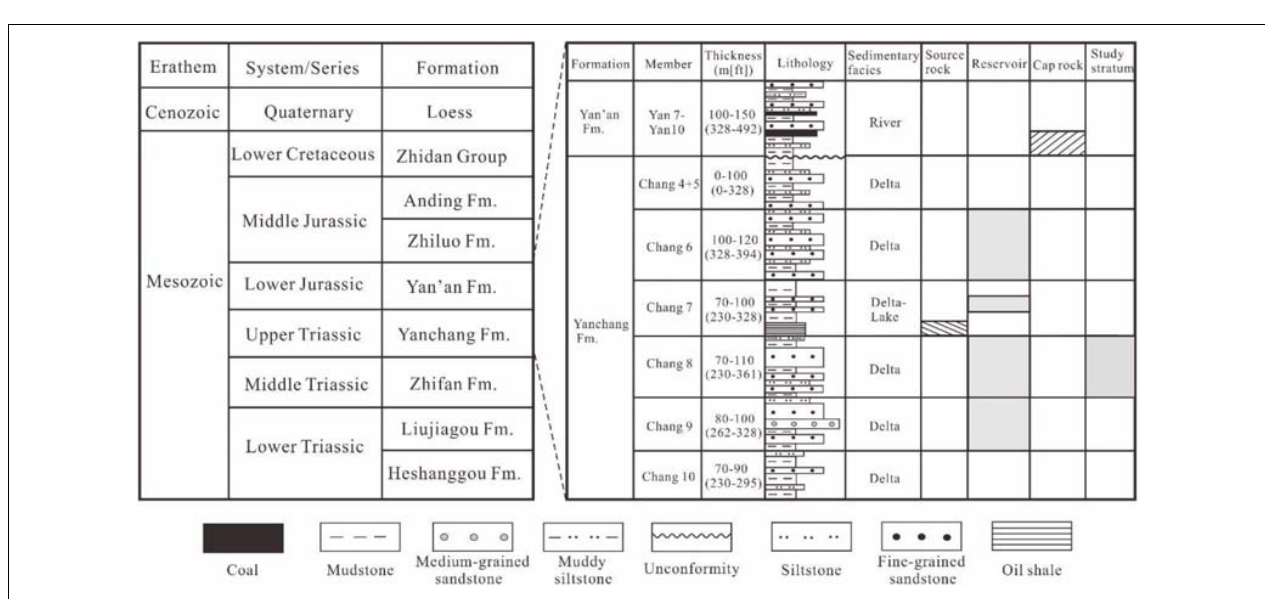
FIGURE 2 | Schematic stratigraphy and hydrocarbon potential of the southwestern Ordos Basin (modified from Lyu et al., 2019). Fm. = Formation.